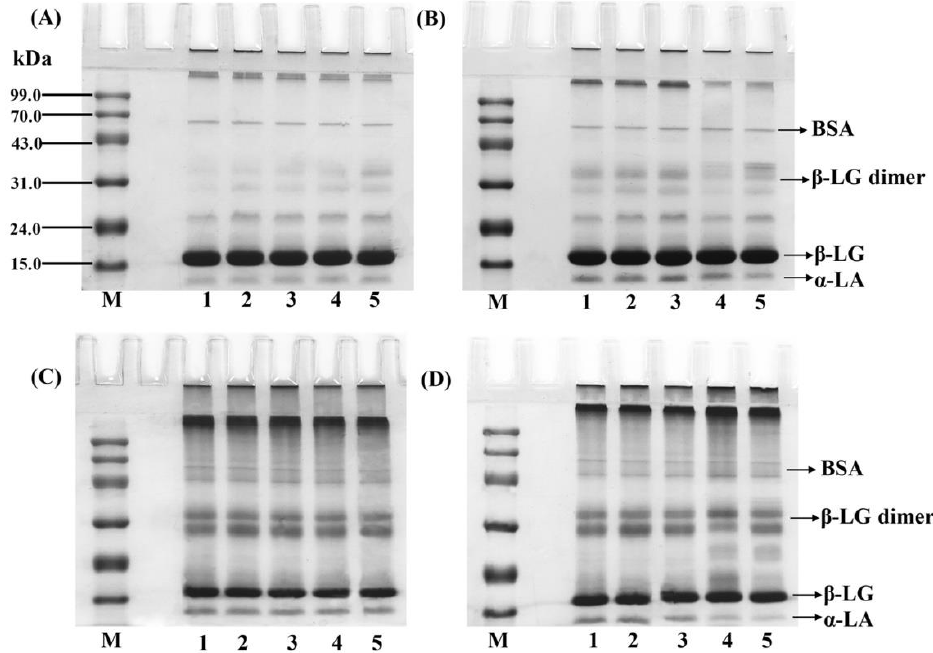
Figure 3. Sodium dodecyl sulfate polyacrylamide gel electrophoresi (SDS-PAGE) of the unadsorbed ( A , B ) and adsorbed proteins ( C , D ) extracted from O/W emulsions oxidized by different addition levels of HPODE and MDA (Lane M: marker; lanes 1–5: 0, 1, 10, 100, and 1000 µ mol/L emulsion) after 24 h incubation. BSA: bovine serum albumin; β -LG: β -lactoglobulin; α-LA: α-lac- talbumin.